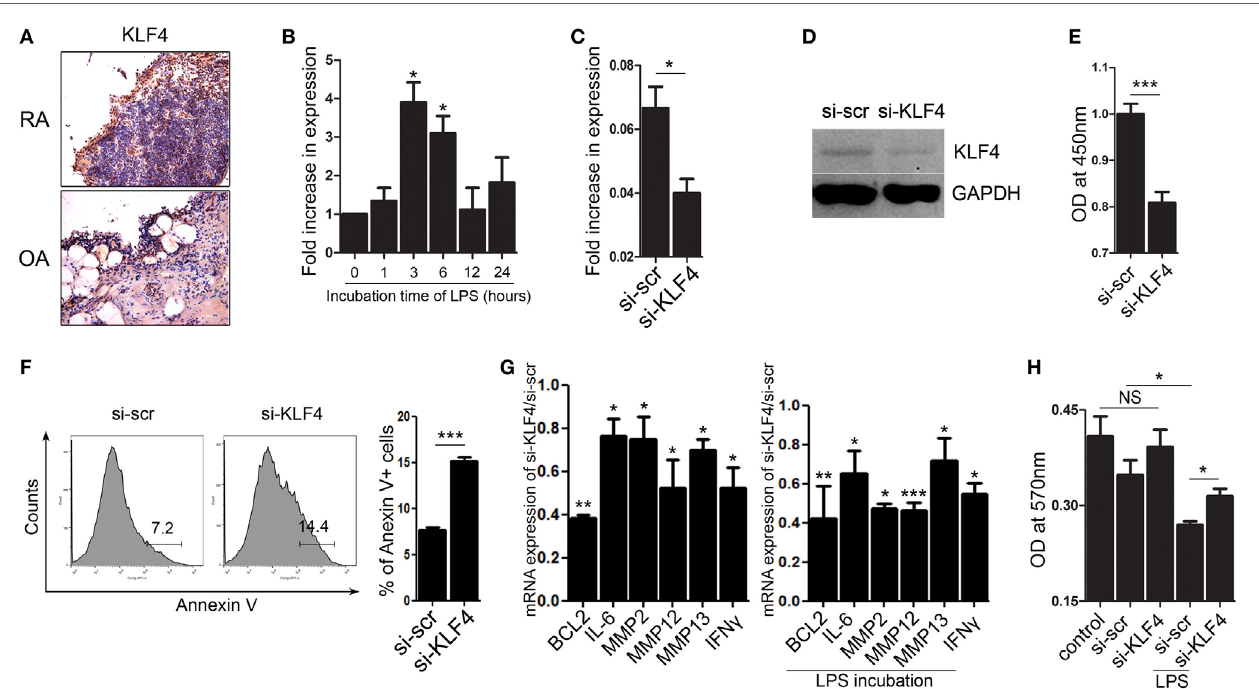
FigUre 6 | Kruppel-like factor (KLF) 4 regulates human fibroblast-like synoviocyte (FLS) cell survival and expression of inflammatory factors and matrix metalloproteinases. (a) Representative images of anti-KLF4 antibody-stained joint tissues from patients with rheumatoid arthritis (RA) and osteoarthritis. (b) Expression of mRNA encoding KLF4 in human FLS in response to lipopolysaccharide (LPS) (as measured by qRT-PCR n = 3). (c,D) , Expression of KLF4 mRNA and protein by FLS transduced with scrambled small-interfering RNA (si-scr) and si-KLF4. (e) Proliferation of FLS transduced with si-scr and si-KLF4 (as measured in a CCK-8 assay). (F) Representative flow cytometry plots showing Annexin V-stained human FLS transduced with si-scr and si-KLF4 ( n = 4). (g) Left panel: ratio of expression of mRNA encoding BCL2, IFN- γ , MMP2, MMP12, and matrix metallopeptidase 13 (MMP13) in FLS transduced with si-KLF4 to that in FLS transduced by si-scr in the absence of LPS ( n = 3). Right panel: with LPS treat for 24 h (as determined by real-time quantitative polymerase chain reaction) ( n = 3). (h) Analysis of collagen degradation using culture medium from si-scr- and si-KLF4-transduced FLS treated (or not) with LPS. Control samples were incubated with phosphate- buffered saline. Values are expressed as the mean ± SEM (* P < 0.05, ** P < 0.01, and *** P < 0.001). Values in panel (b) are generated from a comparison between control (0 h) and LPS-treated human